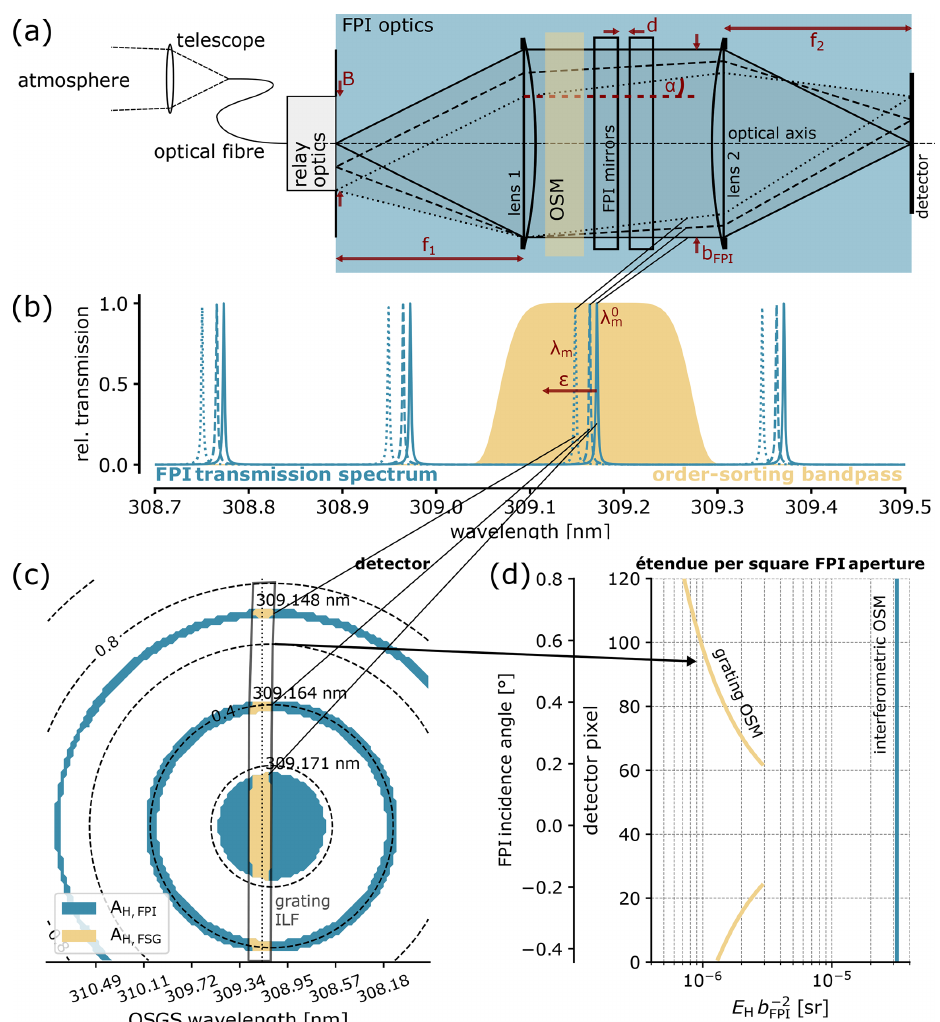
Figure 2. Schematic optical set-up of an FPI spectrograph: (a) light from the atmosphere is directed to the spectrograph entrance via a telescope, an optical fibre, and, if needed, relay optics. The order-sorting mechanism (OSM), depending on its implementation, can be at different locations within the optical path. Lens 2 images the different FPI incidence angles onto the image plane; thus, different spectral FPI transmission spectra (b) are separated on the focal plane detector (c) . The dashed circles in panel (c) indicate the corresponding FPI incidence angle α (in degrees). The OSM isolates a single FPI transmission order, either via filters (interferometric) or via a grating (see grating ILF in c ). Panel (d) shows the étendue per square FPI aperture for the two OSMs and the instrument parameters in Table